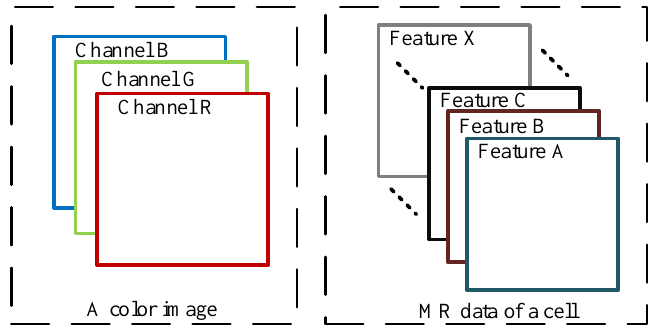
Figure 2. Structural similarity between color image and